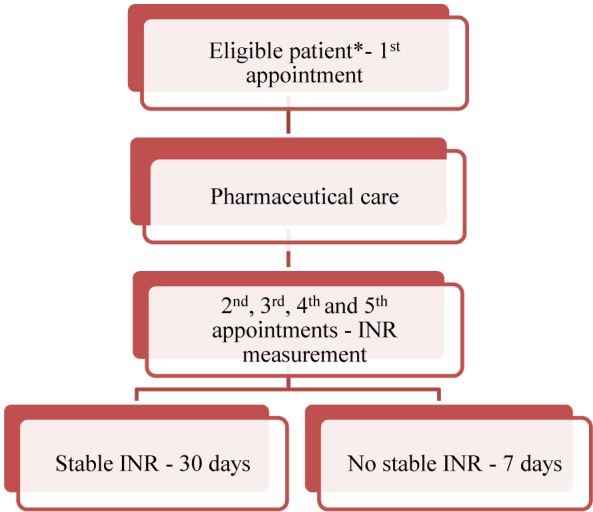
Protocol’s study design. ∗The patients were included in the study if they met the inclusion criteria. Pharmaceutical care consisted of providing the medication, explaining about warfarin administration requirements and the AF disease, as well as informing the individual’s dosage by phone on the day following the first appointment. On the 1st, 2nd, 3rd, and 4th visit, which occurred at an interval of 7 days each, INR was measured. If the INR was stable, the patient returned in 30 days. But, if the INR was not stable, the patient returned in 7 days. The follow-up of each individual lasted for 12 weeks.